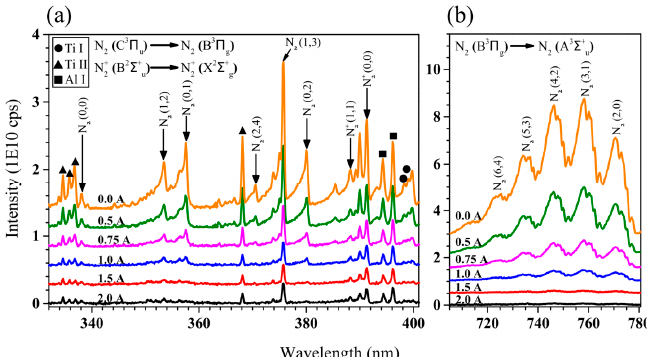
Figure 4. Substrate bias current, deposition rate, charge-to-mass ratio ( Q / M ), and burning voltage as a function of the coil current applied during growth.